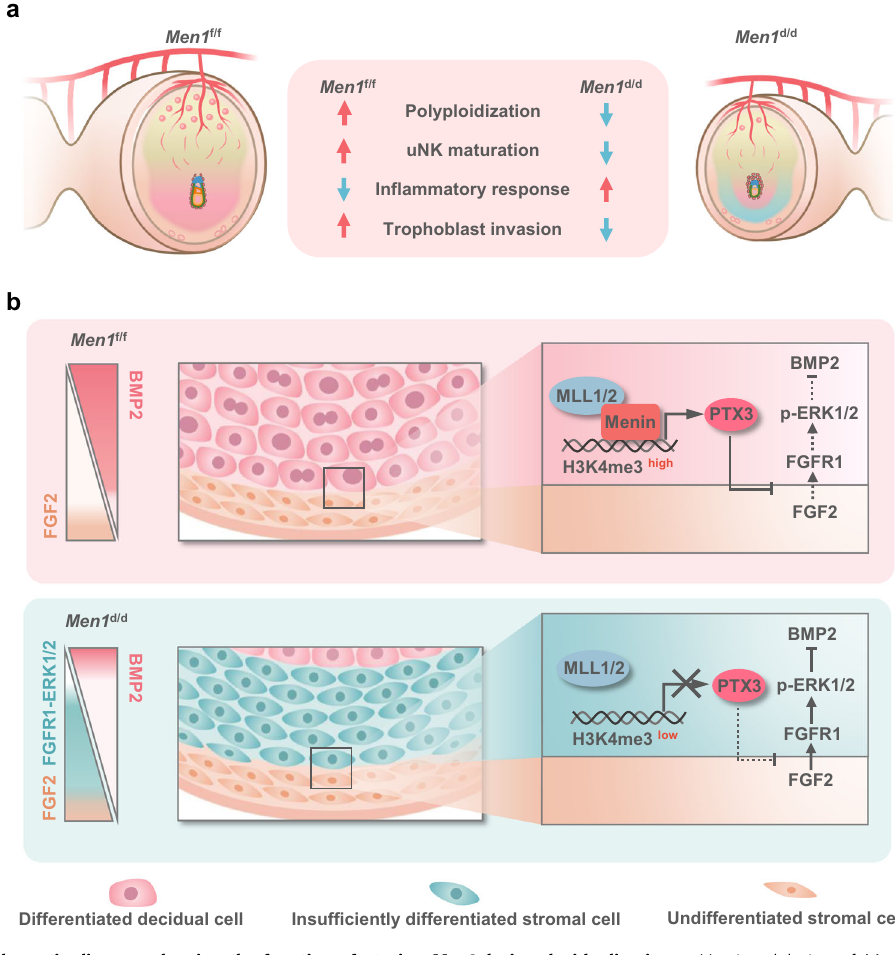
Fig. 8 A proposed schematic diagram showing the function of uterine Men1 during decidualization. a Uterine deletion of Men1 leads to abnormal polyploidization of decidual cells in the SDZ, accompanied by impeded maturation of uNK cells, increased in fl ammatory response, and shallow trophoblast invasion. b Menin positively regulates the expression of Ptx3 in an H3K4me3 dependent manner. PTX3, trapping FGF2 from undifferentiated stromal cells, ensures the expression of BMP2 in the SDZ by inhibiting the activation of